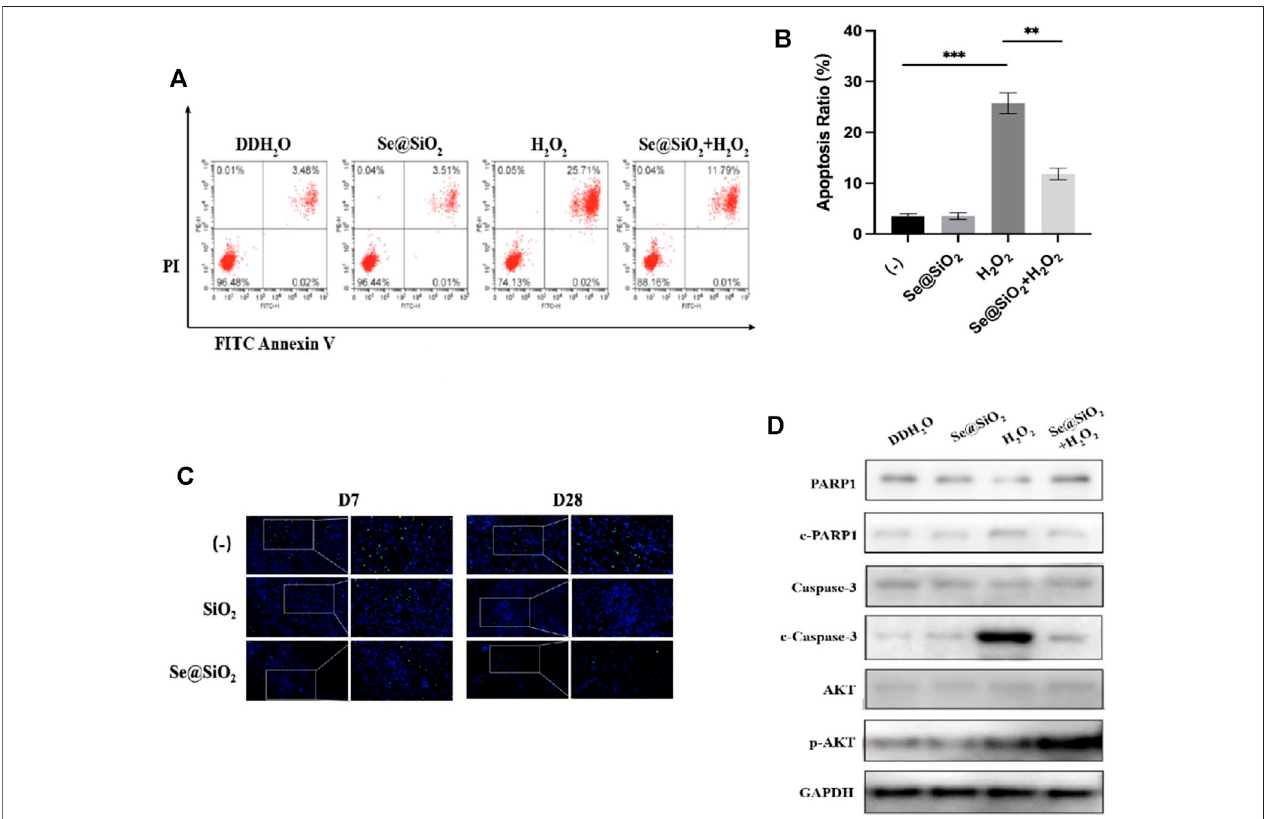
FIGURE 5 | Se@SiO 2 NPs can ef fi ciently attenuate ROS-mediated apoptosis via PI3K/Akt activation. (A) Flow cytometry was conducted to detect the HSF apoptosis after pretreatment with 30 μ g/ml Se@SiO 2 NPs for 24 h, followed by coculture with 300 μ M H 2 O 2 or DDH 2 O for another 24 h. (B) Statistical analysis of the apoptoticcellpercentage. (C) Immuno fl uorescence forTUNELstaining(green)wasperformedtovalidatetheresultsof fl owcytometryanalysis.Nucleiwerestainedwith DAPI (blue) (D) Relative expression levels of PARP1, c-PARP1, Caspase-3, c-Caspase-3, AKT and p-AKT proteins were detected via western blotting. * p < 0.05, ** p < 0.01 and *** p < 0.001. Abbreviations: PI3K/Akt, Phosphatidylinositol 3-kinase/Akt; DDH 2 O, double distilled H 2 O; TUNEL, TdT mediated dUTP Nick End Labeling; PARP1, poly ADP-ribose polymerase 1; c-PARP1, cleaved poly ADP-ribose polymerase 1; c-Caspase-3, cleaved Caspase-3; p-AKT, Phosphorylated